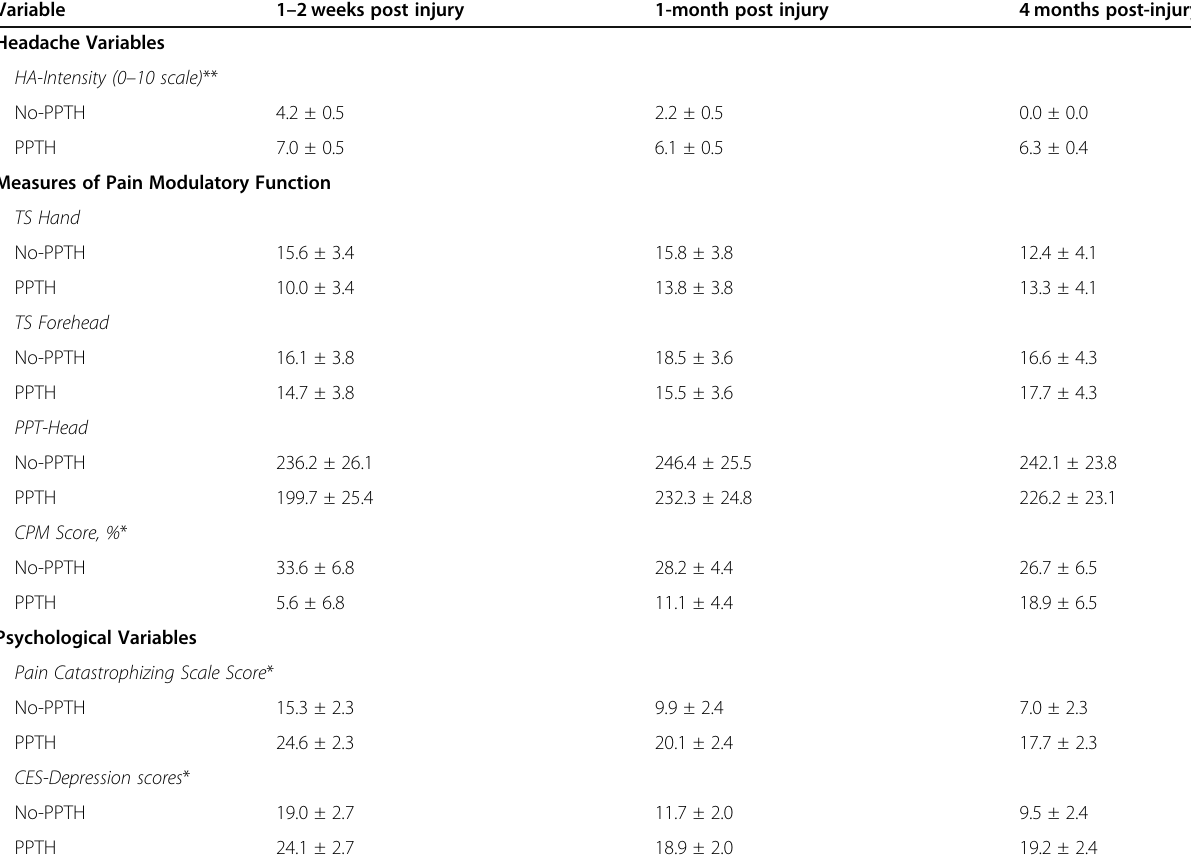
Table 2 Means and SE ’ s of primary outcome variables across time for the PPTH and no-PPTH group